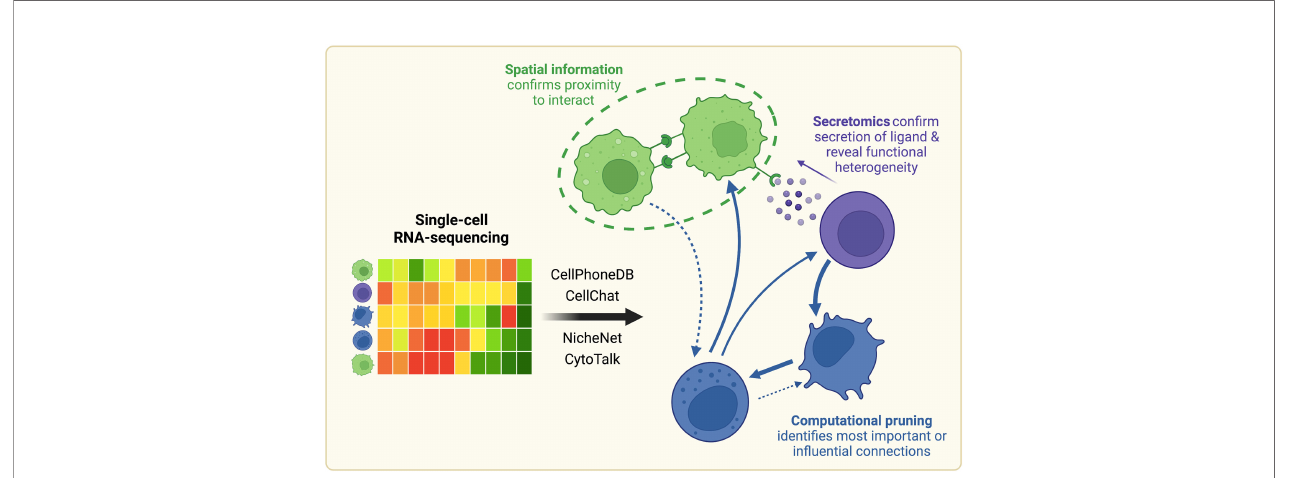
FIGURE 1 | Once scRNA-seq-derived cell-cell communication networks are mapped, spatial pro fi ling, protein-level measurements, and computational pruning can aid validation and interpretation. Cell-cell communication can be inferred from scRNA-seq using a variety of computational methods, such as CellPhoneDB, CellChat, NicheNet, or CytoTalk. Experimentally, connections between cell populations can be validated with spatial pro fi ling and protein-level measurements. Networks can also be further analyzed computationally with network analysis and mathematical modeling tools. Created with